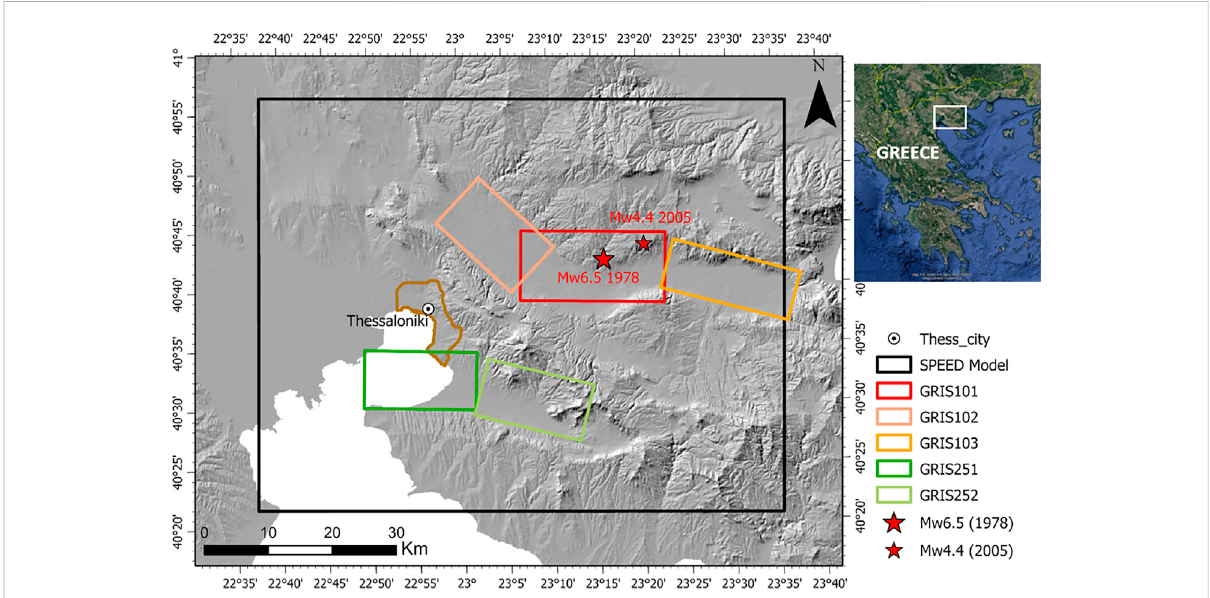
FIGURE 1 Overview of thestudy area with indication of themain seismogenic faults (according to theGreDaSS database) and the Thessalonikiurban area